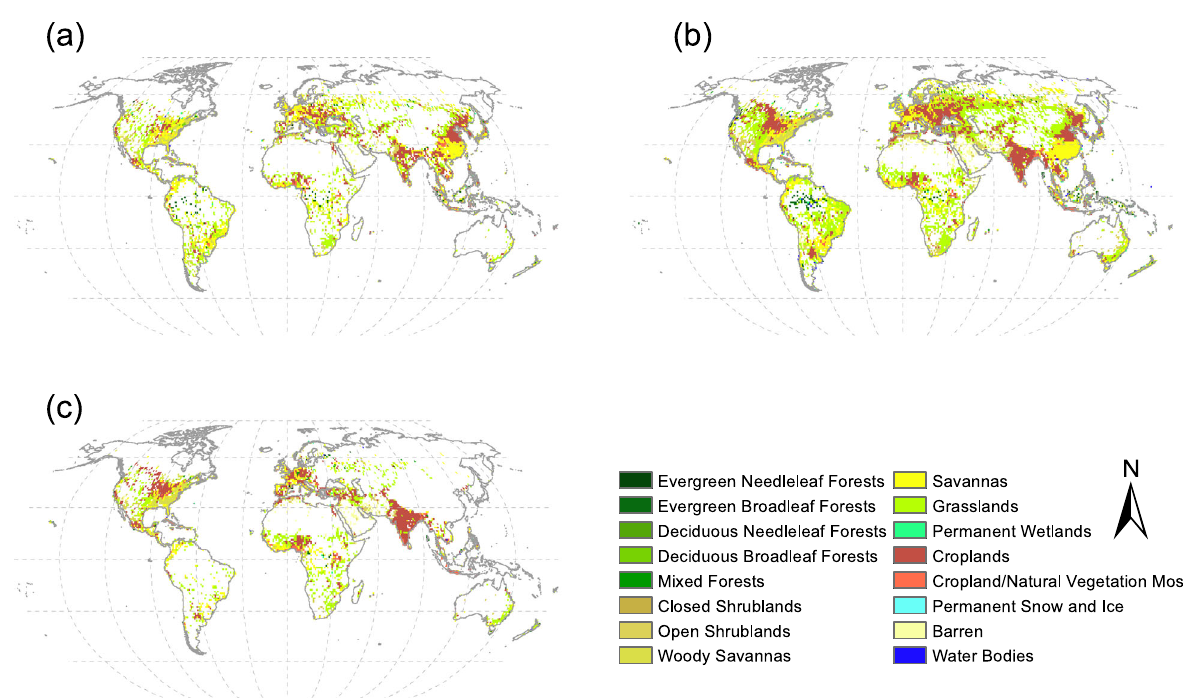
Fig. 2 Dominant land cover converted to urban land. The land cover types with the most area being converted into urban land at grid-level in each 1° grid a in 2018 relative to 2001, b in 2050 relative to 2018, and c in 2100 relative to 2050 under SSP2 scenario. See Supplementary Fig. 2 for results under SSP1 and SSP5